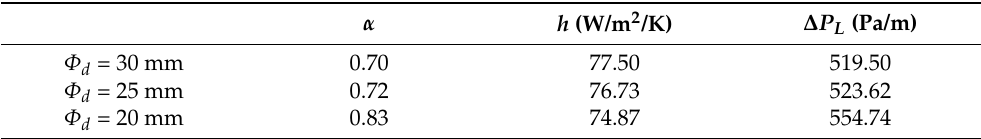
Table 4. Thermo-hydraulic performance of the DF-PCHE channels with three kinds of hole diameter 3 × 3 SPBs using ∆ L = 150 mm cross-section as